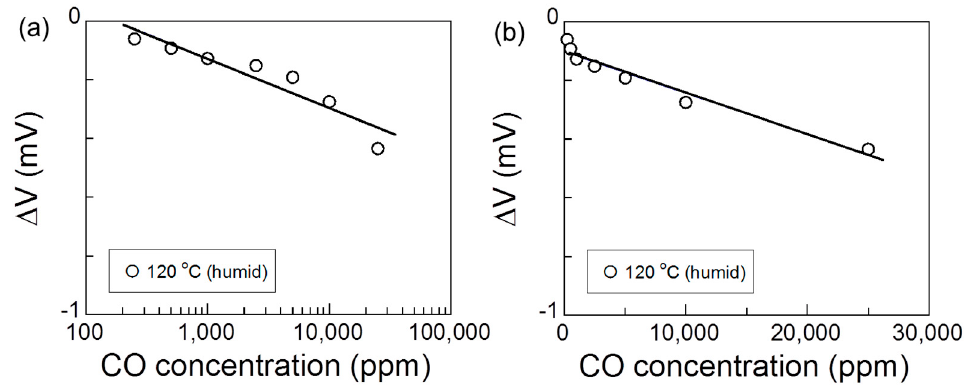
Figure 7. ( a ) The relationship between the sensor response and the logarithm of the CO concentration and ( b ) the relationship between the sensor response and the CO concentration in humid air at 120 °C. The solid lines show the least-squares linear fit.